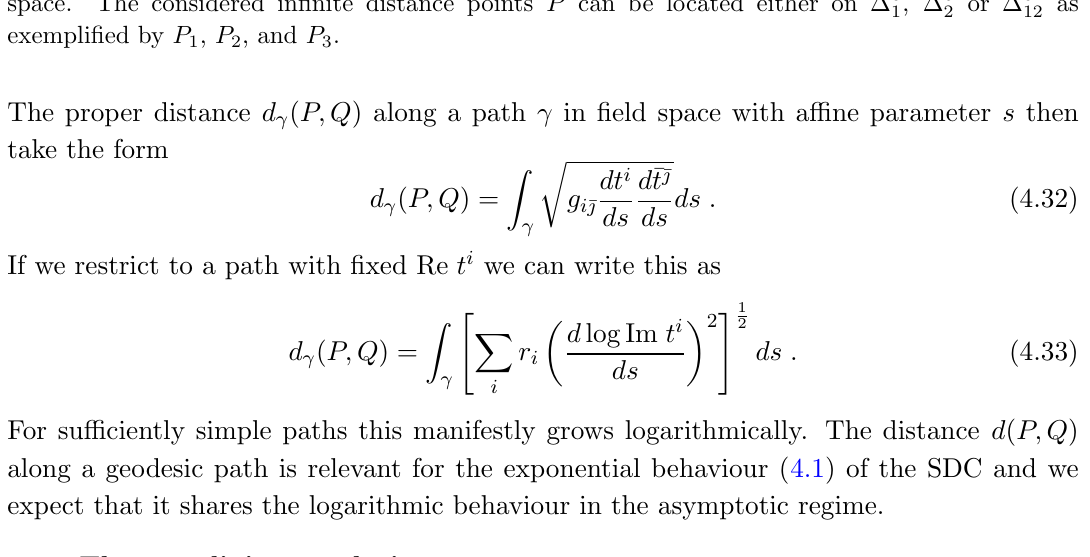
as , (cid:1) (cid:14) or (cid:1) (cid:14) 1 2 12